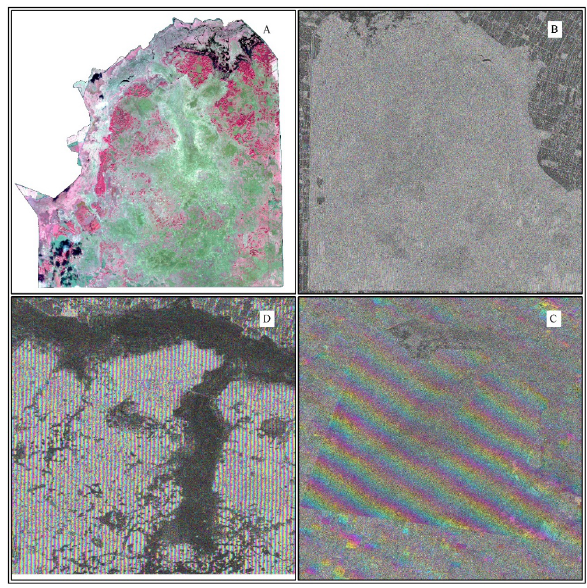
Figure 2 the interferogram of the study area using three SAR data: A was the RGB image derived from wavelet fusion of GF-1 multispectral image and HH polarization Radarsat-2 backscattering intensity data. B was the interferogram generated by X-band TerraSAR images; C was the interferogram generated by C-band Sentinel-1A images; D was the